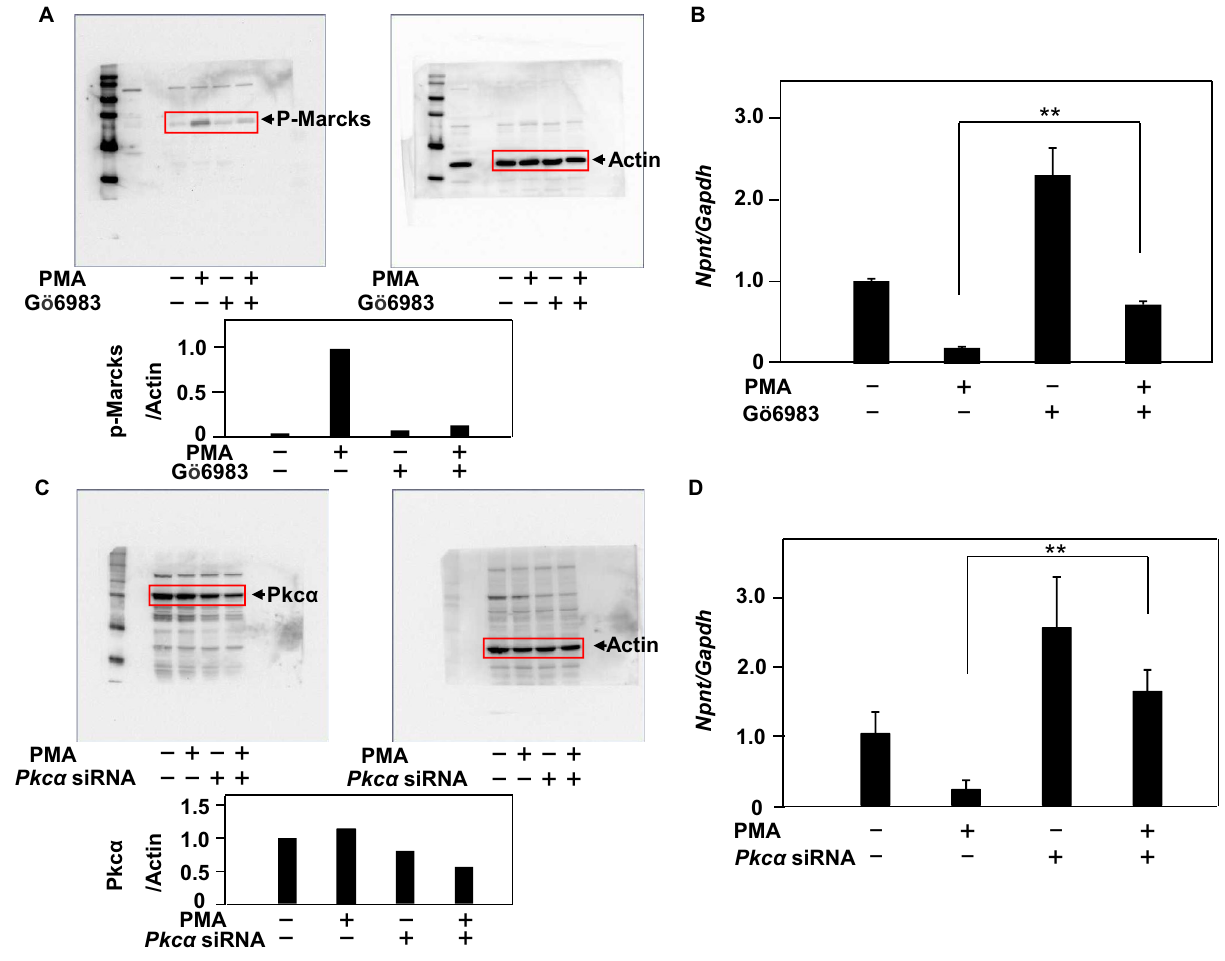
Figure 4. PKC signaling, especially PKCα, is involved in Npnt gene down-regulation by PMA. ( A ) MC3T3-E1 cells were starved for 16 h in serum-free medium. Next, they were pretreated with or without Gö6983 (500 nM) for one hour, and then with PMA (5 nM) alone or in combination for five minutes. Proteins were extracted and subjected to western blotting to detect phosphorylation of Marcks (p-Marcks) and actin. ( B ) MC3T3-E1 cells were pretreated with or without Gö6983 (500 nM) for one hour, and then treated with PMA (5 nM) alone or in combination for 24 h. Total cellular RNA was extracted, and mRNAs for Npnt and Gapdh were examined using real-time PCR analysis. ( C ) MC3T3-E1 cells were pretreated with or without Pkcα siRNA (20 nM) for 24 h, and then treated with PMA (10 nM) alone or in combination for 24 h. Proteins were extracted and subjected to western blotting to detect Pkcα and actin. ( D ) Total cellular RNA was extracted, and mRNAs for Npnt and Gapdh were examined using real-time PCR analysis. Results are shown as the mean ± SD of three samples. ** P < 0.01, Student’s t-test, as compared to presence or absence of PMA, Gö6983, and Pkcα